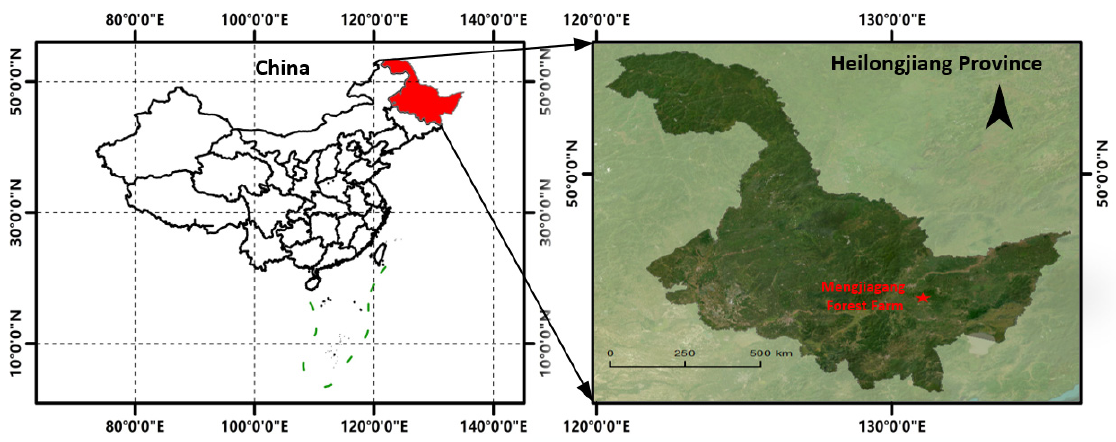
Figure 1. Map of the Mengjiagang forest farm in Heilongjiang Province, northeast China, showing the study area location.